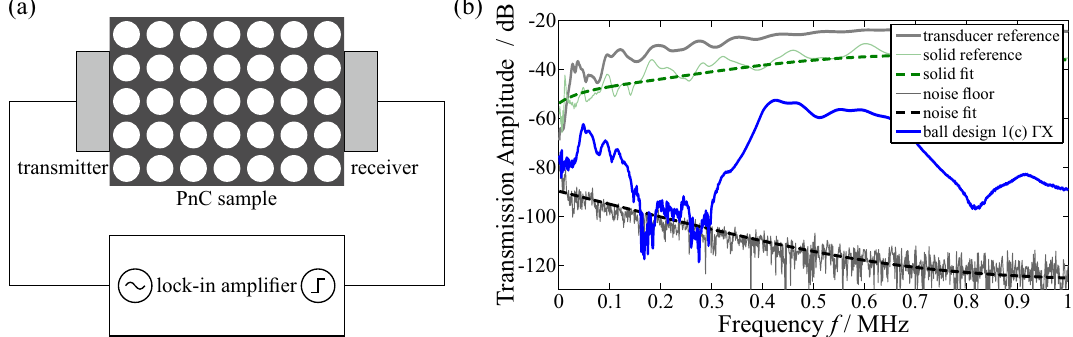
Figure 7. ( a ) transmission measurement setup with two ultrasonic transducers clamped on opposite sides of the PnC sample; ( b ) measured transmission spectra of longitudinal transducers in direct contact (solid gray), upper reference curve and fit through a solid sample of the same material and similar length (dashed green), lower reference of noise floor and fit (dashed black), and exemplary measurement curve of ball design Figure 1c in direction Γ